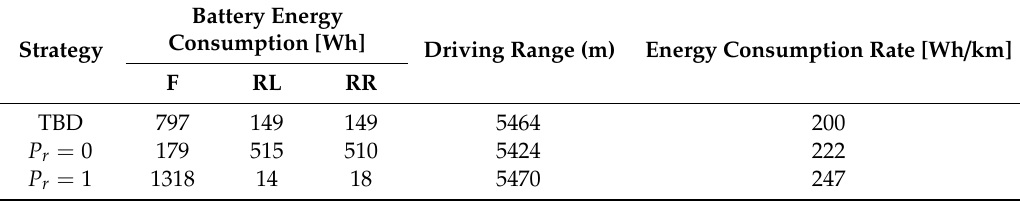
Table 5. Battery energy consumption in road